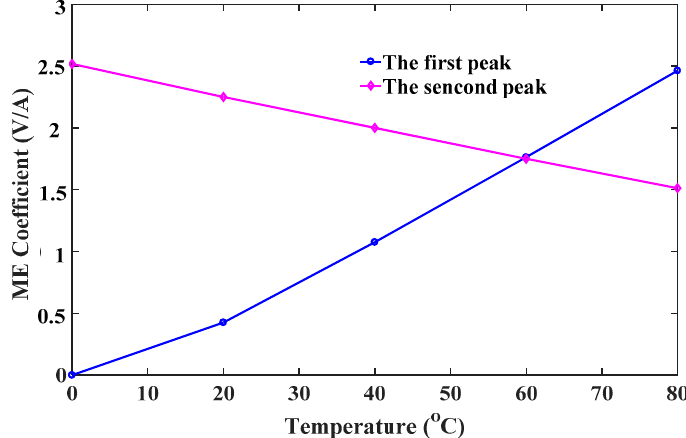
Materials 2018 , 11 , x FOR PEER REVIEW Figure 10. The ME coefficient varied with magnetic field under different temperatures.